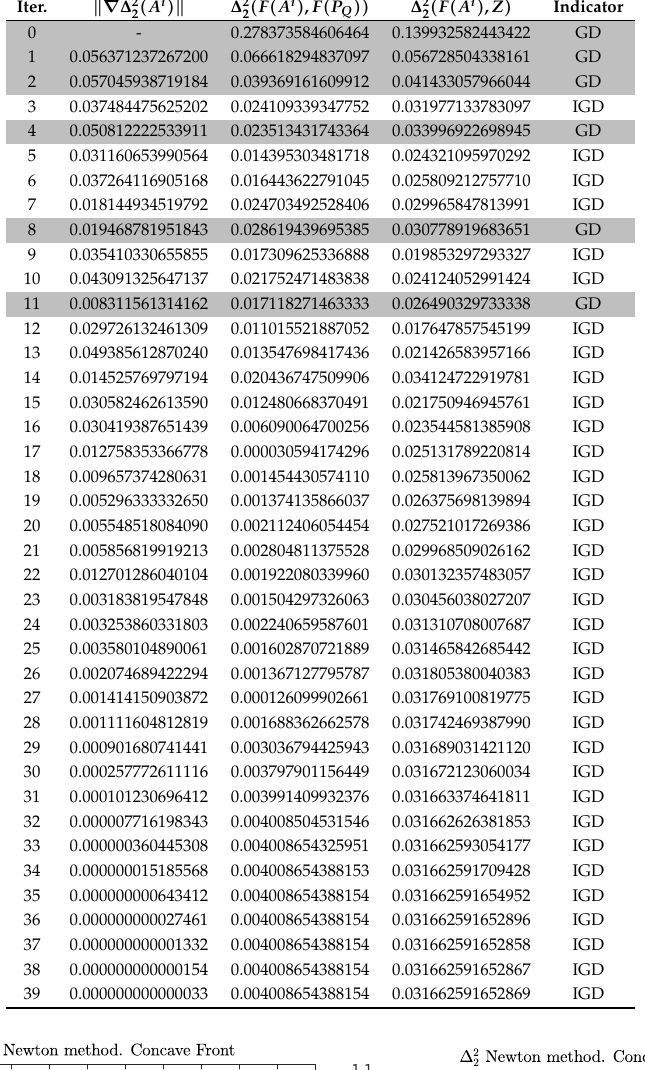
-Newton method on BOP (50), see Figure 12. 2